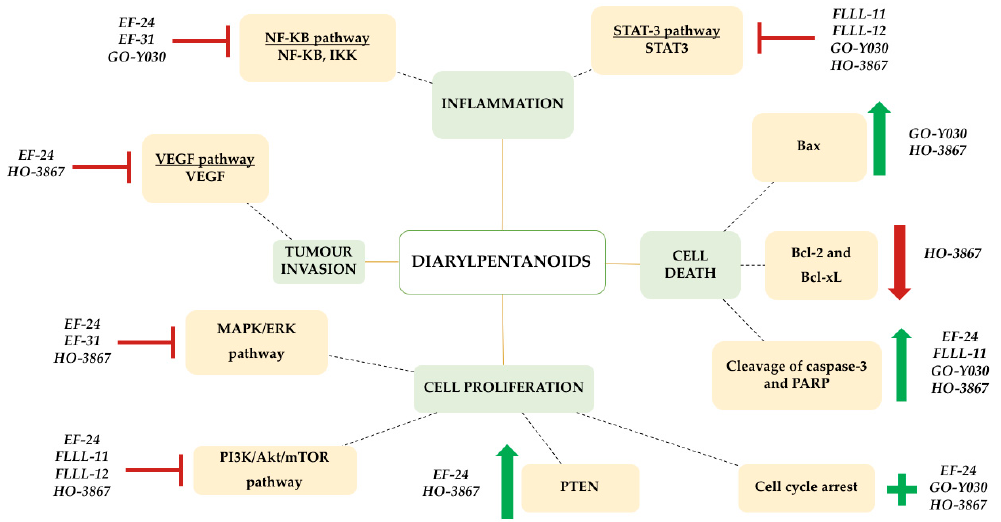
Figure 2. The effects of diarylpentanoids (DAPs) on inflammation, cell death, cell proliferation, and tumour invasion in in vitro and in vivo cancer models by the modulated expression of specific target molecules/pathways (yellow boxes). Green arrows denote up-regulated expression and red arrows denote down-regulated expression. Pathways that have been inhibited by particular DAPs are expressed using a red ‘ ’ symbol, while induction is represented by a green ‘ + ’ symbol.